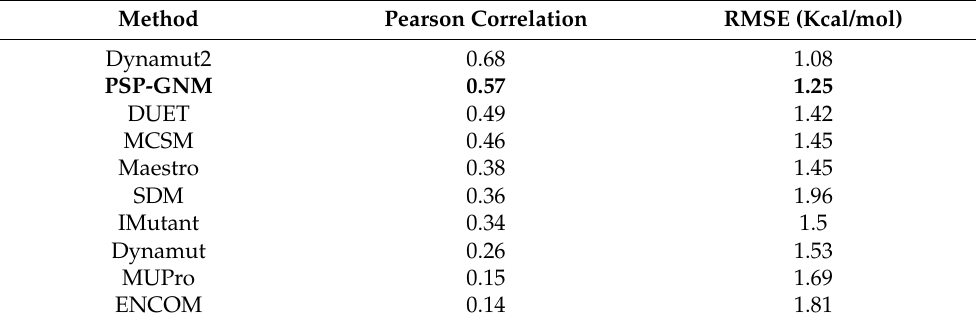
Table 5. Performance on S611 dataset for a subset of 564 mutations with a PSP-GNM-calculated ∆∆ G. The 564 mutations had at least one contact broken, both in the wildtype and mutant forms, for the residue at the mutation position when simulating unfolding with PSP-GNM. The performance for PSP-GNM is shown in